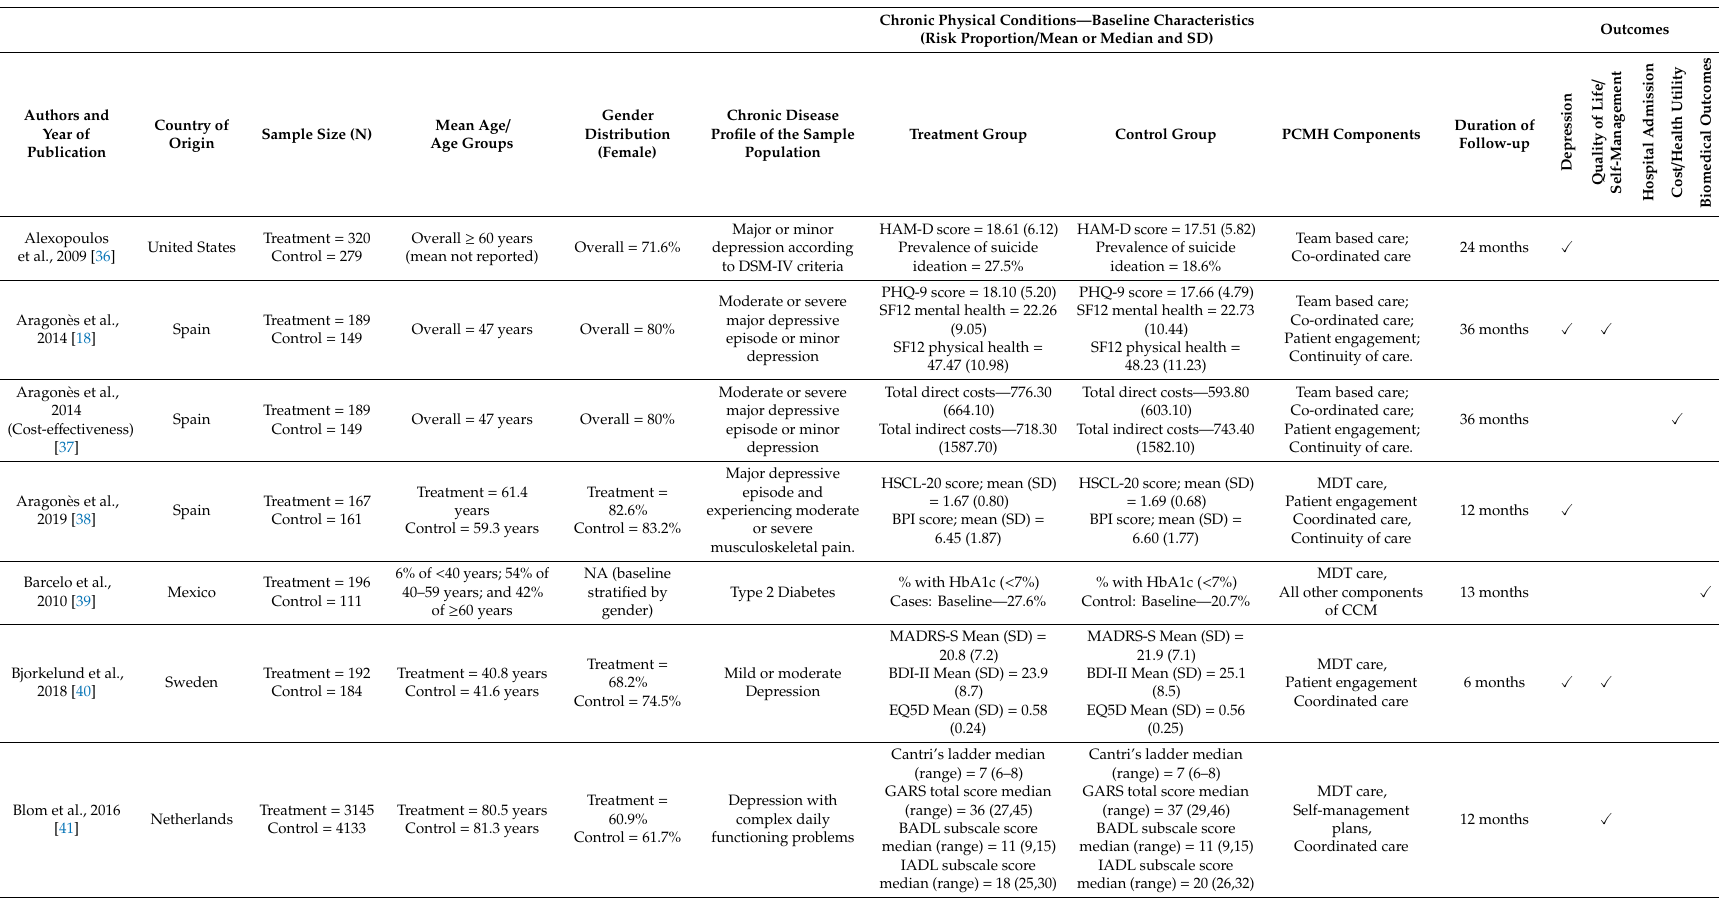
Table A3. Characteristics of randomised controlled trials